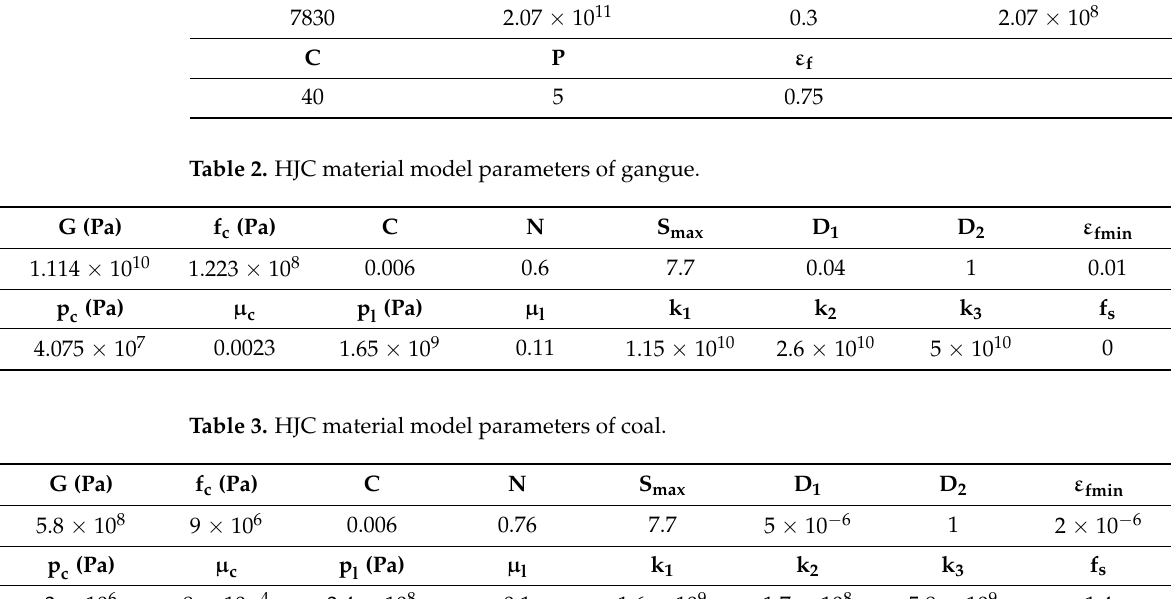
Table 2. HJC material model parameters of gangue.